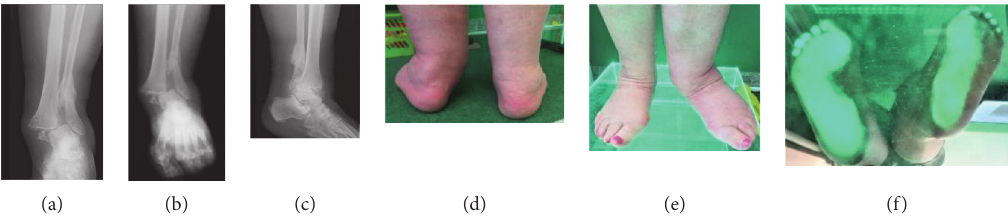
Figure 2: (a– f) Results of imaging tests (X-ray) and podoscopic tests: patient no. 2. (a) Posterior-anterior X-ray; fracture of the medial ankle and fracture of the distal end of the fibula. (b) Anterior-posterior X-ray: fracture of the medial ankle, fracture of the distal end of the fibula, overload changes in the phalangeal joints, and inflammation in the metatarsal joints. (c) Lateral X-ray: microfractures of the heel bone and enthesopathy of the plantar fascia: calcaneal spur. (d) Posterior picture: ankle joint and hindfoot evaluation. (e) Anterior picture of the feet: assessment of toe positioning and deformation. (f) Plantar photo on the podoscope: assessment of plantar part of the foot, height measurement of the longitudinal arch.